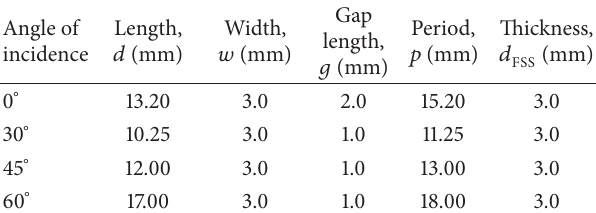
Table 1: Design parameters of SSL-FSS. Angle